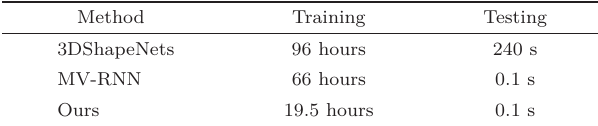
Table 4 Training and testing time for our method